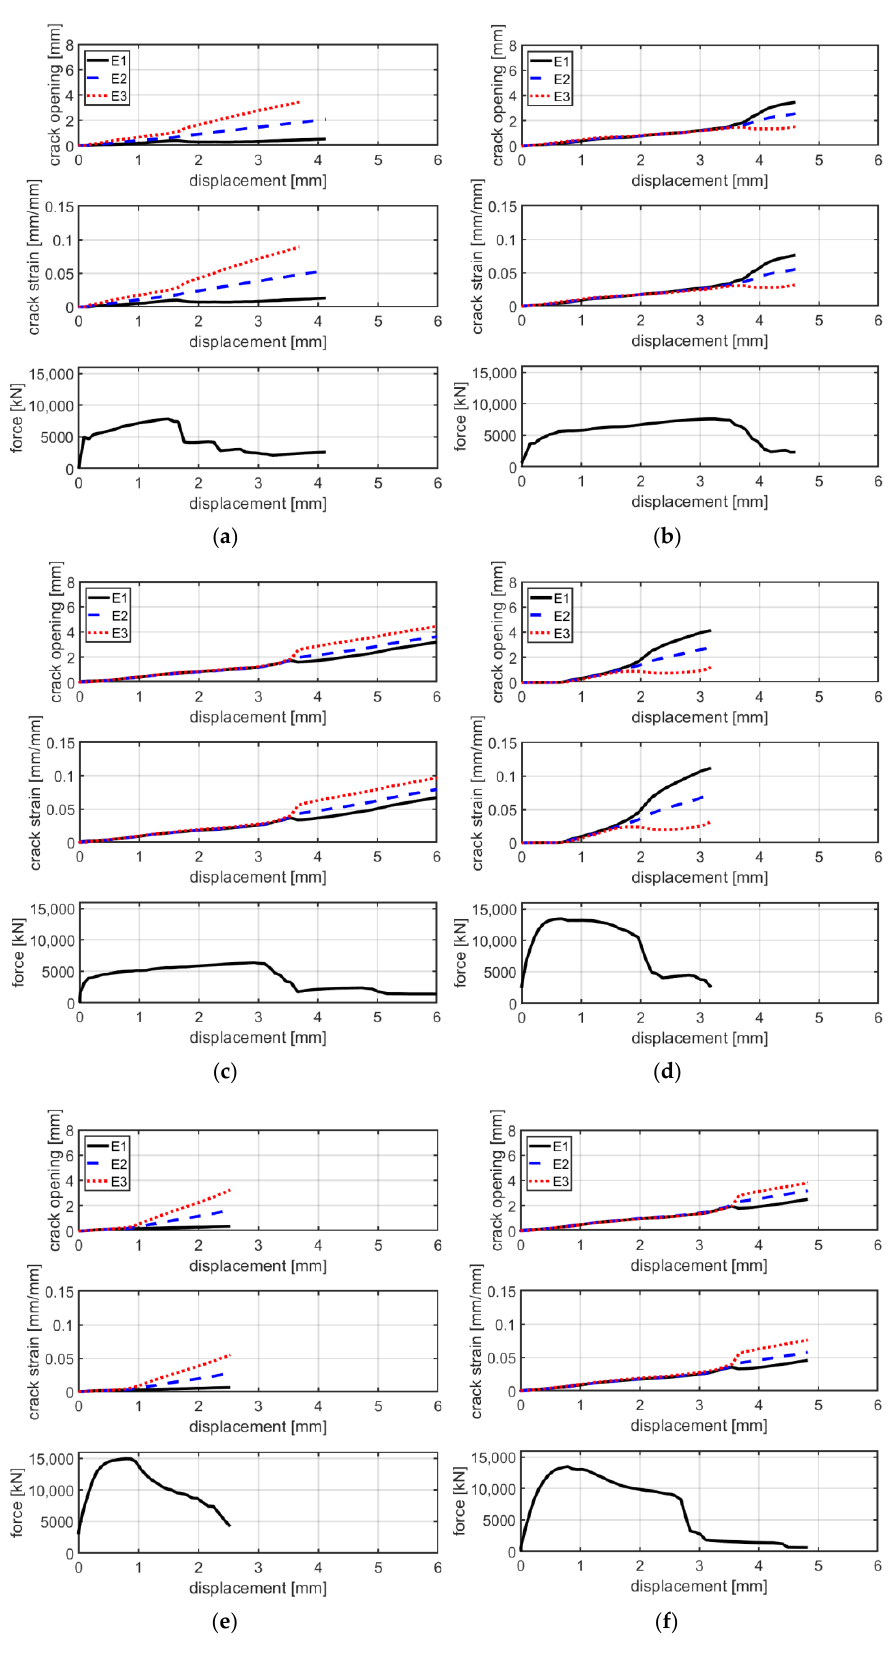
Figure 15. Graphs of crack opening/crack deformation/force-axial displacement of specimens